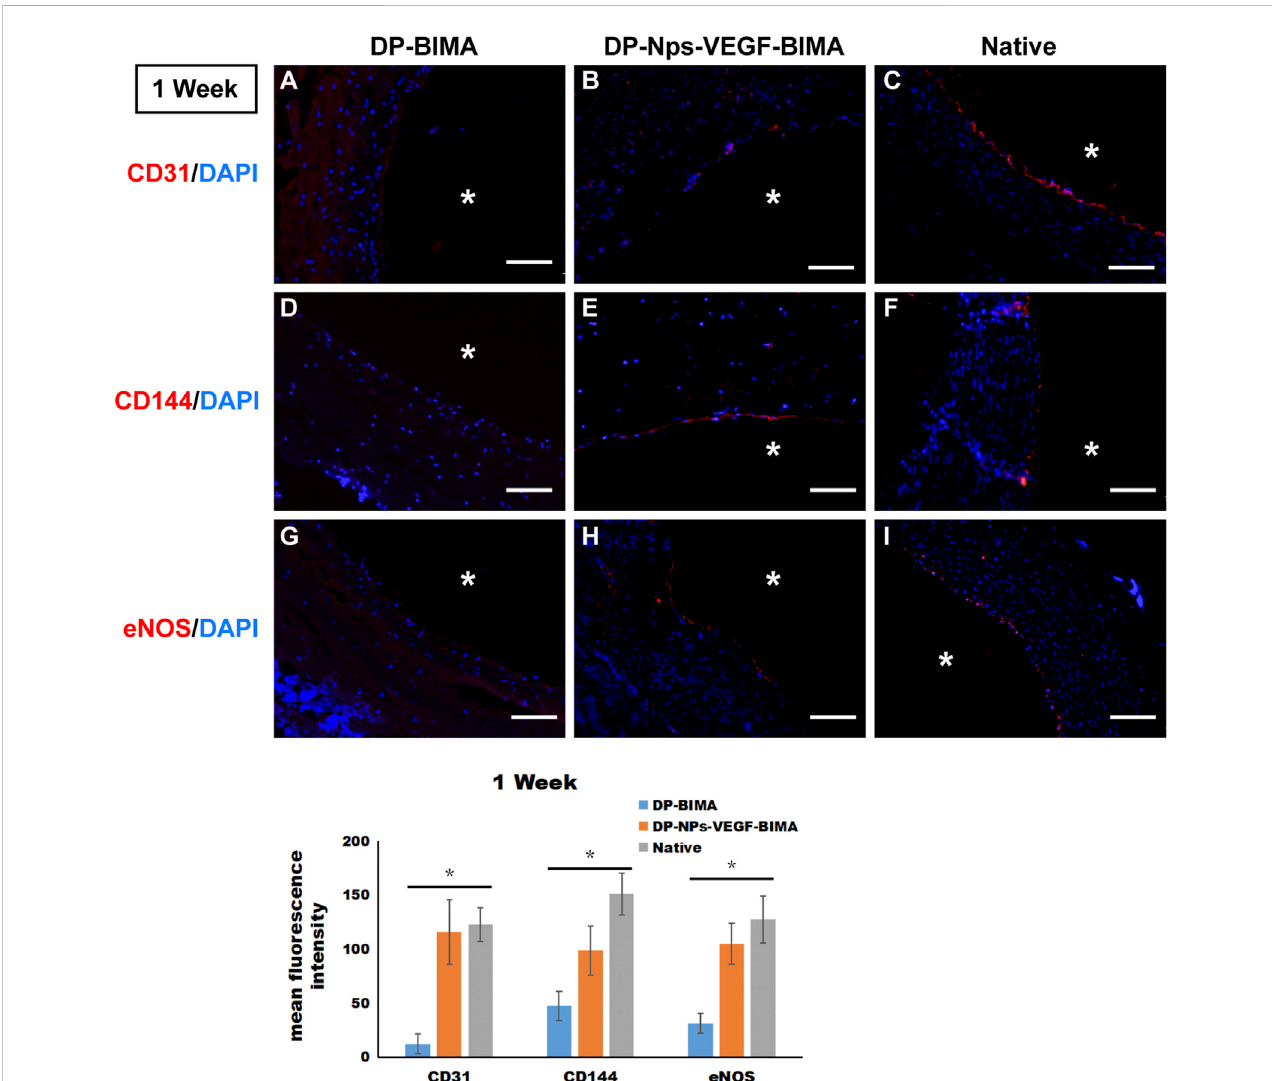
FIGURE 10 The immuno fl uorescent staining results of CD31, CD144, and eNOS. Samples are native rabbit aorta, and the grafts of the two groups which were implanted for 1 week. (A – C) were the staining of CD31 and DAPI for DP-BIMA, DP-Nps-VEGF-BIMA, and native rabbit aorta, respectively. (D – F) were the staining of CD144 and DAPI for DP-BIMA, DP-Nps-VEGF-BIMA, and native rabbit aorta, respectively. (G – I) were the staining of eNOS and DAPI for DP-BIMA, DP-Nps-VEGF-BIMA, and native rabbit aorta, respectively. * indicates the lumen of the grafts. Scale bars indicate 100 μ